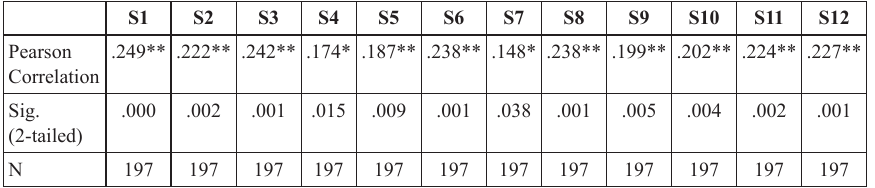
Table 4. Correlation between the questionnaire answers distribution and the affiliation to control or experimental